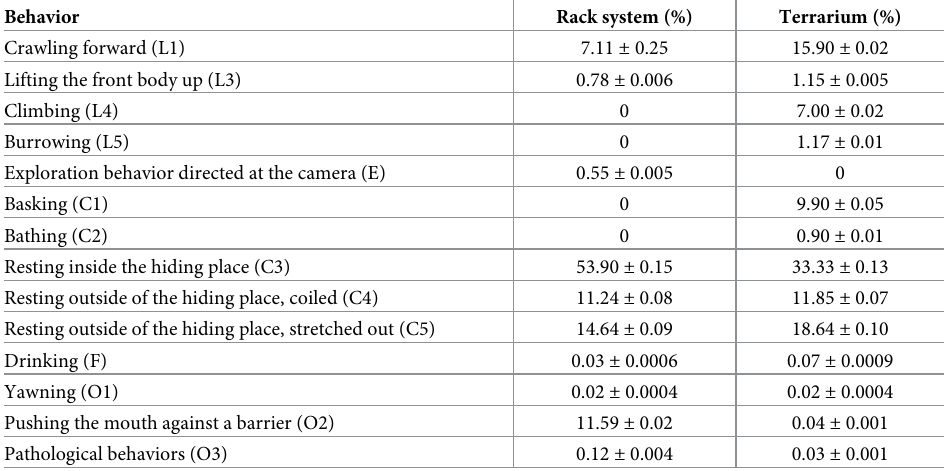
Table 3. Comparison of the relative frequency of all behaviors displayed in 24 hours in the two housing systems (rack system and terrarium).